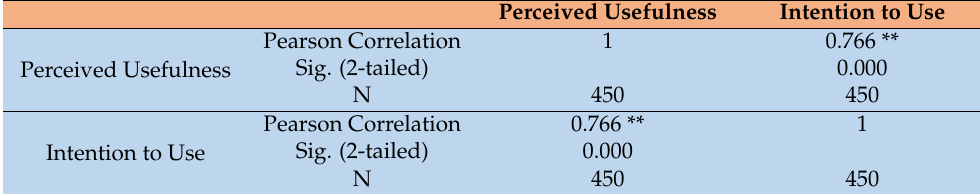
Table 14. Results of the correlation analysis for hypothesis 9